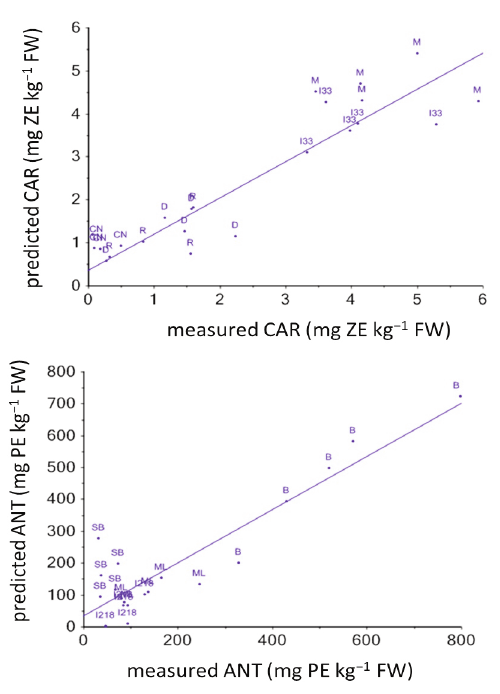
Fig. 3 ­ Measured and predicted flesh color of white­yellow (top) and purple (bottom) potato genotypes by PLS